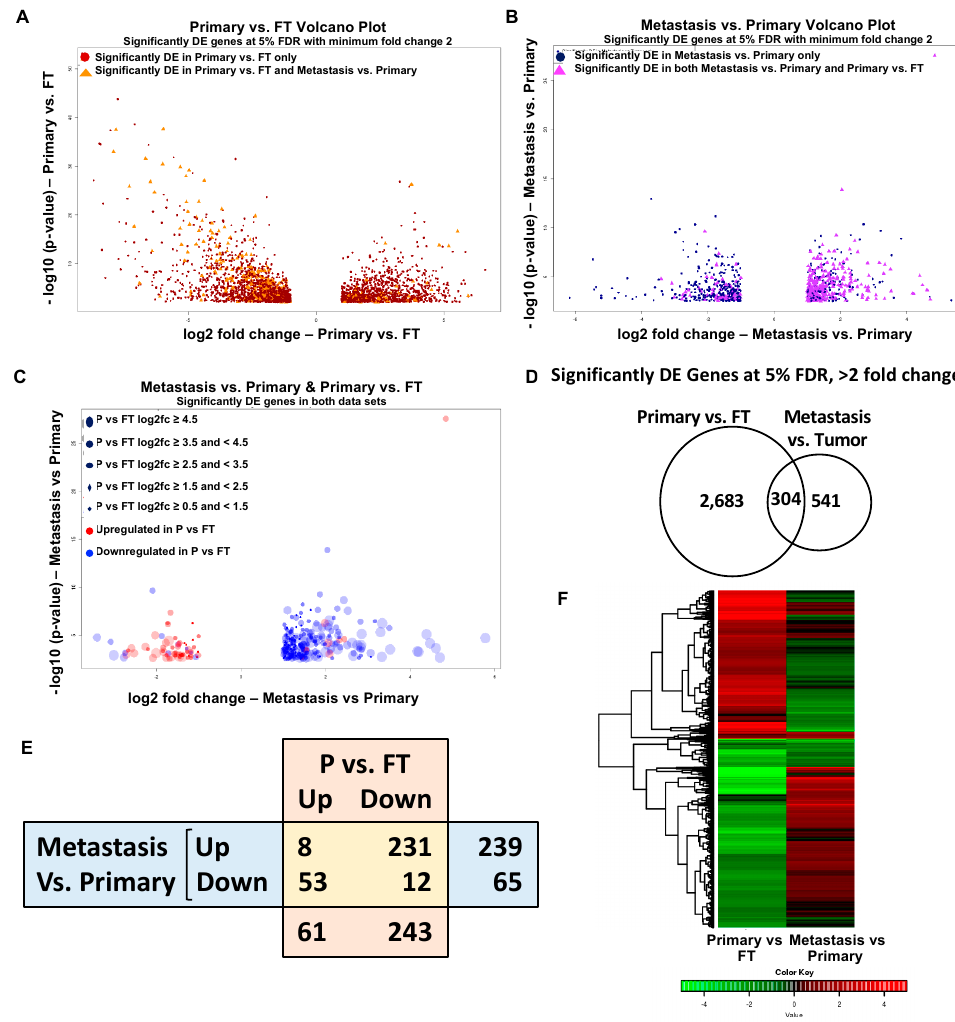
Figure 4. Gene expression analysis in ovarian cancer. ( A ) Volcano plot representing di ff erentially expressed (DE) genes for primary tumors versus fallopian tube (red dots), where the di ff erentially expressed genes common to both primary tumors versus fallopian tube and metastasis versus primary tumors are highlighted (orange triangles). The − log 10 ( p -values) plotted against log2 fold change values for all the significantly di ff erentially expressed genes at 5% FDR with at least two-fold change between primary tumors versus FT ( B ) Volcano plot representing di ff erentially expressed genes for metastasis versus primary tumors (blue dots), where the di ff erentially expressed genes common to both primary tumors versus fallopian tube and metastasis versus primary tumors are highlighted (purple triangles). The − log 10 ( p -values) plotted against log2 fold change values for all the significantly di ff erentially expressed genes at 5% FDR with at least two-fold change between metastasis versus primary tumors. ( C ) Volcano plot for metastasis versus primary tumors showing only the di ff erentially expressed genes common in both metastasis versus primary tumors and primary tumors versus fallopian tube. Circle size is correlated to the fold change in expression in primary tumors versus fallopian tube. Circles are color coded to depict upregulation (red) or downregulation (blue) in primary tumors versus fallopian tube. ( D ) Venn diagram representing the overlap between primary tumors versus fallopian tube and metastasis versus primary tumors. ( E ) Table representing common upregulated and downregulated genes in ovarian cancer metastasis versus primary tumors and primary tumors (P) versus FT. ( F ) Combined heat map showing the hierarchical clustering based on log2 fold change values of common significantly di ff erentially expressed genes in primary tumors versus fallopian tube and metastasis versus primary